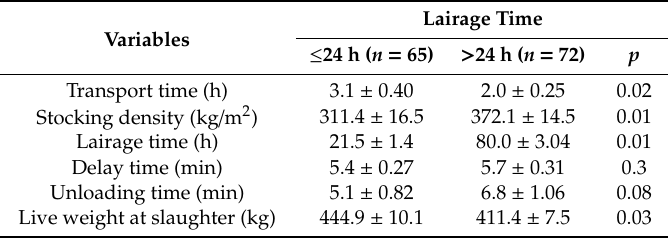
Table 2. Least square means ( ± SE) of the pre-slaughter management practices at two types of lairage time at the abattoir.